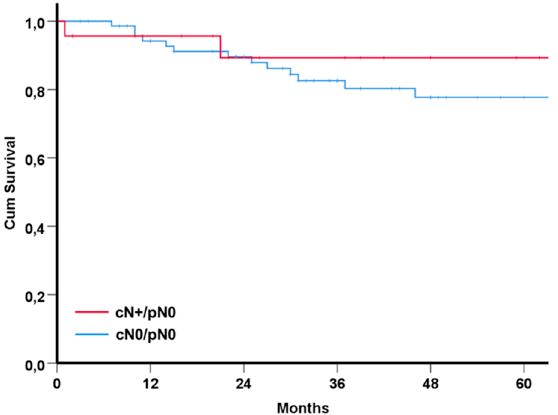
Figure 2. Kaplan–Meier plots of 24 patients with originally planned surgical tumor resection, therapeutic neck dissection and PORT (red line), in whom treatment was finally de-escalated to surgery alone (cases), and patients staged as cN0 (blue line) who were a priori scheduled for primary surgical resection with elective neck dissection only (controls; n = 72; log rank p = 0.74).